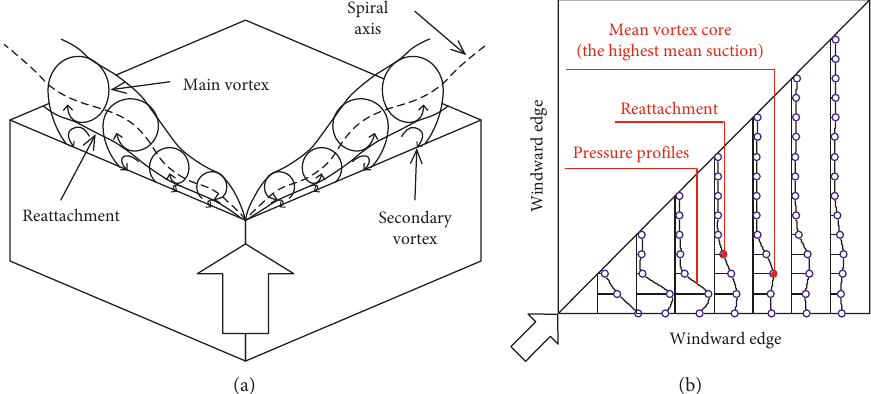
Figure 6: Conical vortices on a flat roof and corresponding mean suction profiles in oblique flow. (a) Conical vortices. (b) Mean suction profiles.